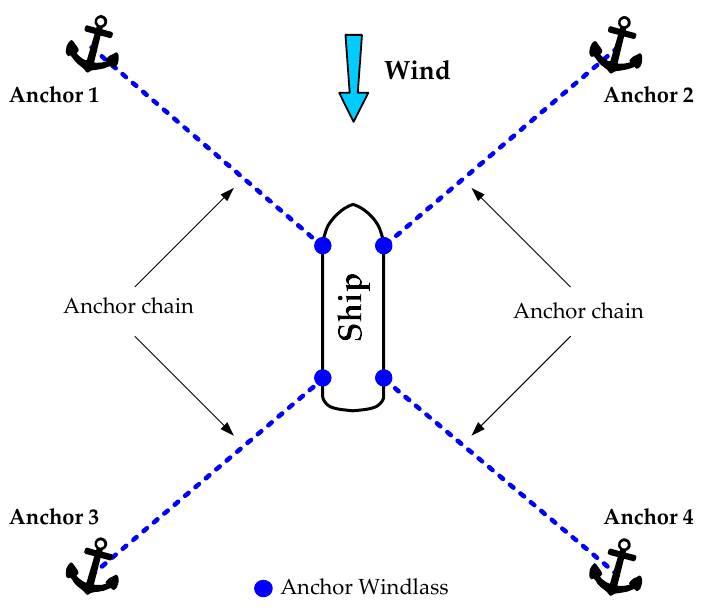
Figure 15. The most popular method of anchoring.